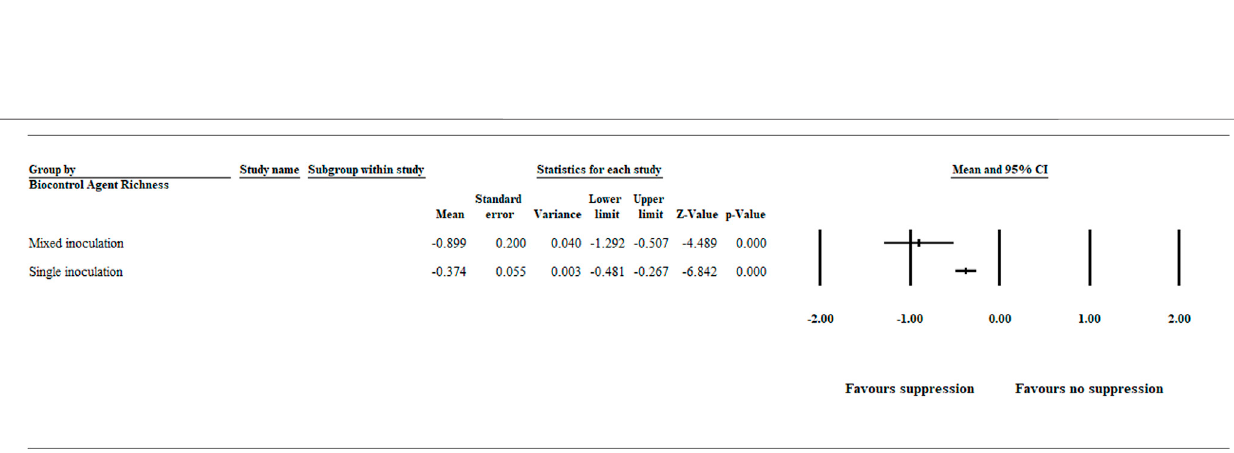
FIGURE 3 | Effect of biocontrol agent richness on aphanomyces root rot suppression. The analysis detected a signi fi cant ( p < .001) negative effect size for mixed and single organism inoculation favoring disease suppression. The center of the horizontal line depicts the effect size, and the width re fl ects its con fi dence interval. Number of studies: Mixed organism inoculation 11; Single organism inoculation 151. CI (cid:1) con fi dence interval.